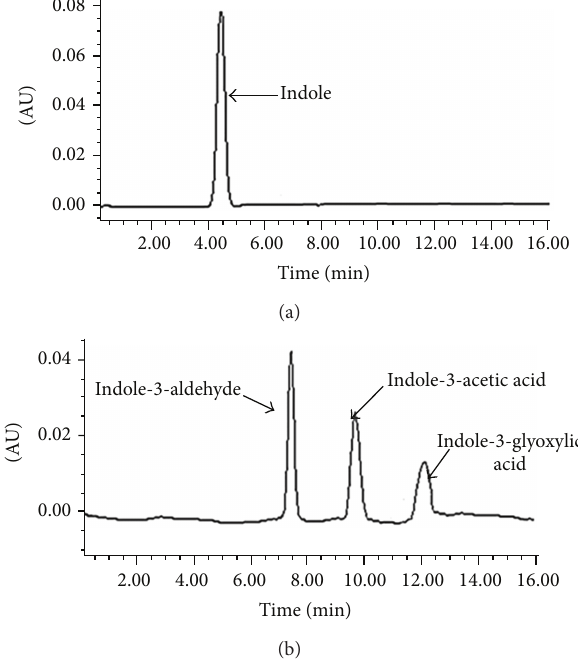
Figure 2: HPLC analysis of samples of indole biotransformation by Arthrobacter sp. SPG. (a) 8h sample showing only peak for indole and (b) 36 h sample showing complete bacterial transformation of indole into indole-3-acetic acid, indole-3-glyoxylic acid, and indole-